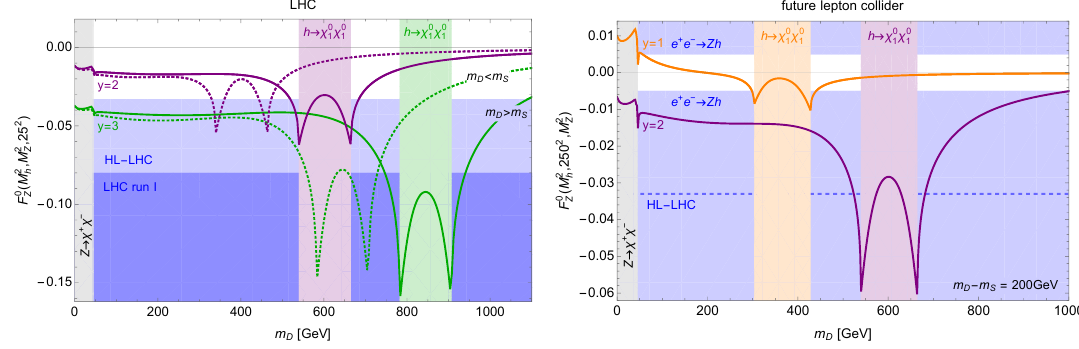
Figure 3 . Anomalous Higgs- Z coupling as a function of the mass parameter m D for (cid:12)xed Yukawa couplings y at the LHC, Re[ F 0 ;pp ], (left) and a future lepton collider with p s = 250 GeV, Re[ F 0 ;ee Z (right). Plain/dotted lines correspond to (cid:12)xed values m D excluded by Z width measurements. In orange, purple, and green regions, invisible Higgs decay h (cid:31) 0 (cid:31) 0 is open for m D m S = 200 GeV and y = 1 ; 2 ; 3, respectively. Dark blue regions have 1 1 ! (cid:0) been excluded at the LHC during run I. Light blue regions can be tested at the HL-LHC and future lepton colliders.